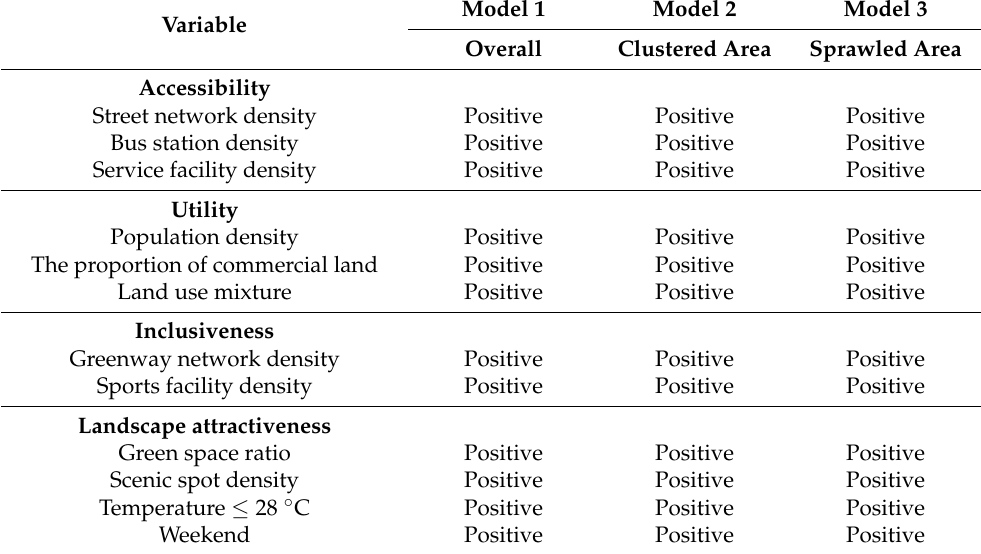
Table 5. The hypothetical models.